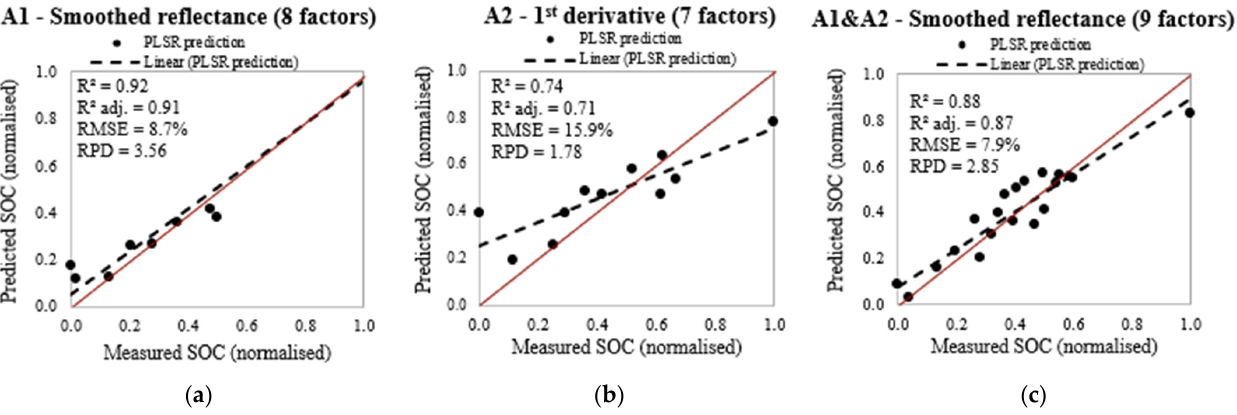
Figure 14. Validation results of the PLSR models for SOC prediction after selecting the spectral bands, for ( a ) smoothed reflectance—A1, ( b ) first derivative—A2, and ( c ) smoothed reflectance—A1&A2.